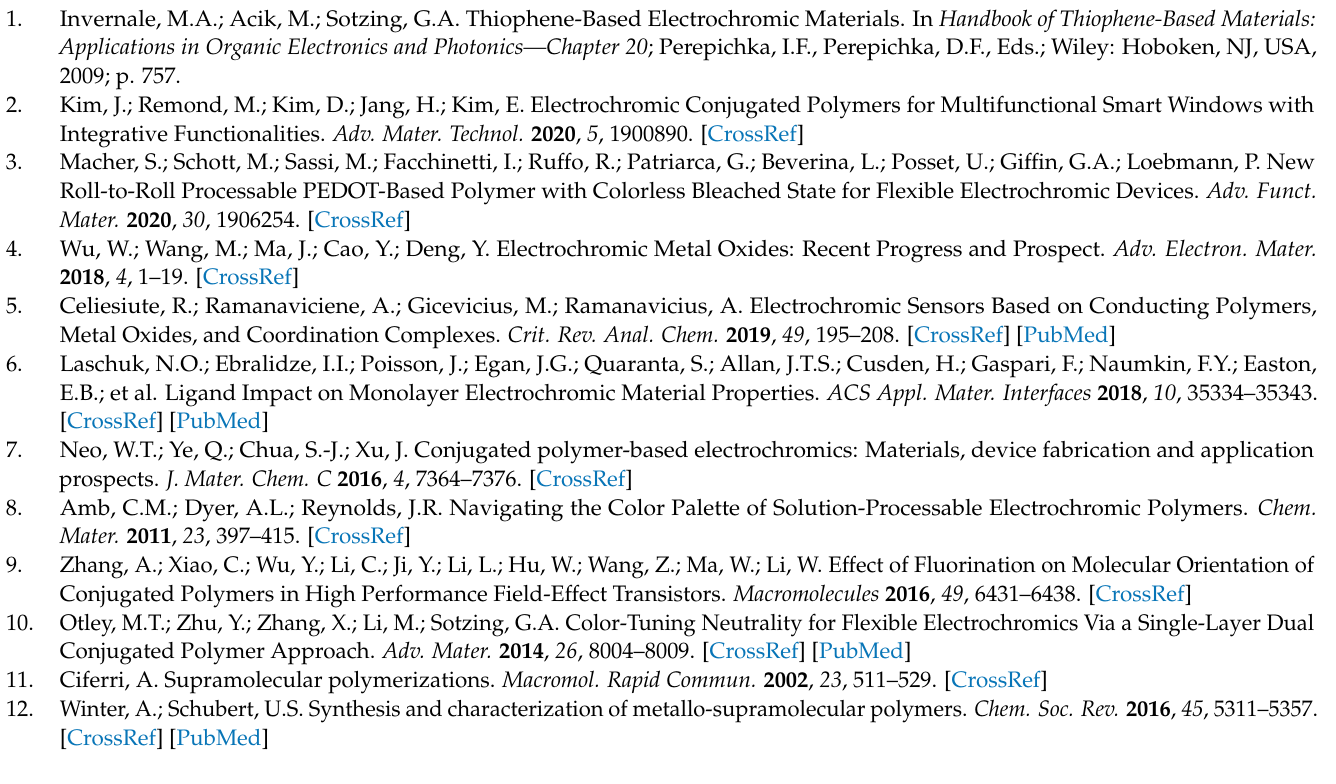
Figure S10: photographs of solutions showing color changes during assembly of MSPs. Figure S11: A comparison of the MLCT bands of all Fe-MSPs. Figure S12 3D AFM images of Fe-MSP films (tapping mode), Figures S13 and S14: Determination of the bleaching and coloring time of electrochromic films. Figure S15: Frequency dependence of the real part of the conductivity of gel electrolyte. Randles-Ševˇcik